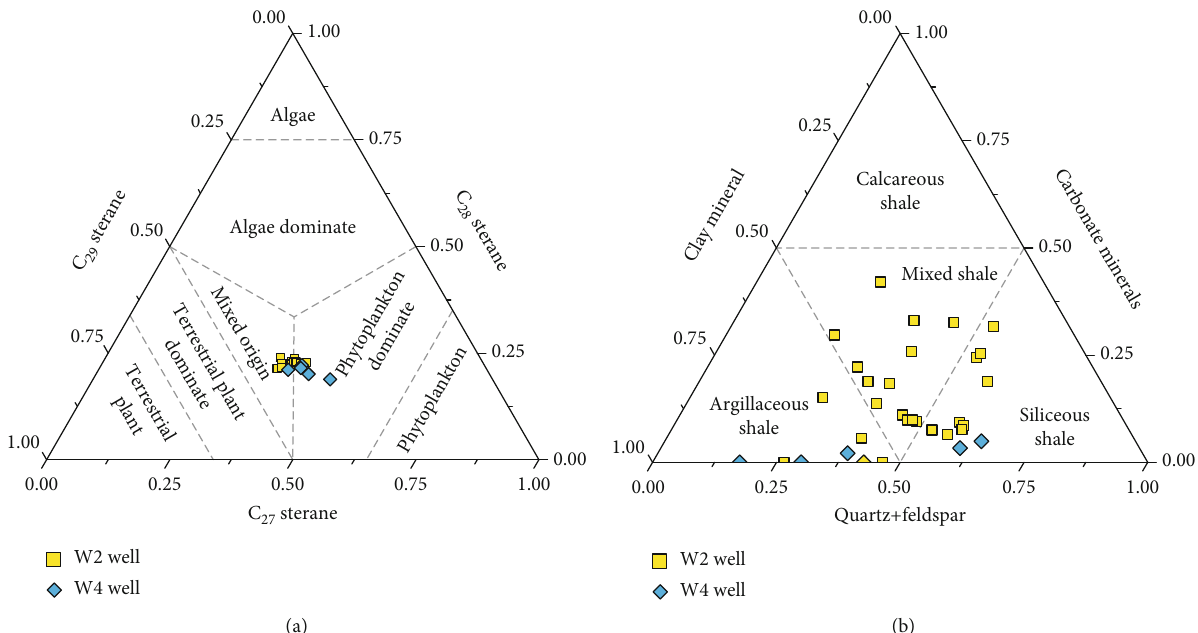
-C -C ) (the basemap is from [31]) and (b) ternary diagram of minerals of the 27 28 29